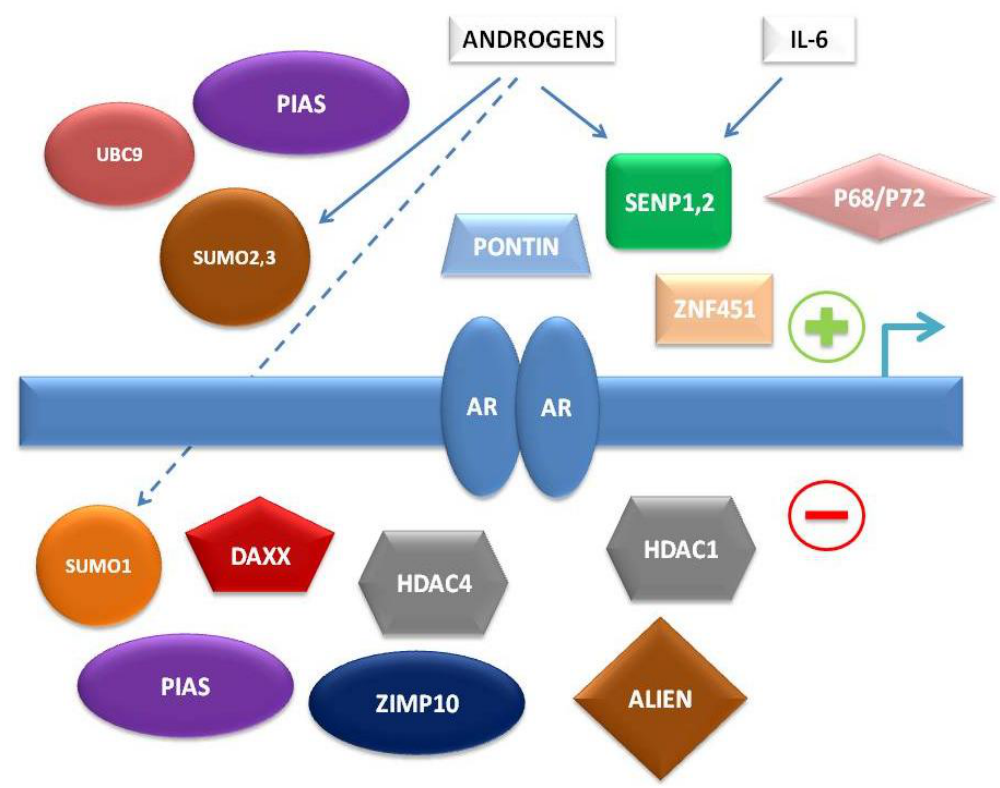
Figure 1. Simplified schema of interconnections between small ubiquitin-related modifier (SUMO) pathway proteins and other factors regulating androgen receptor (AR)-dependent